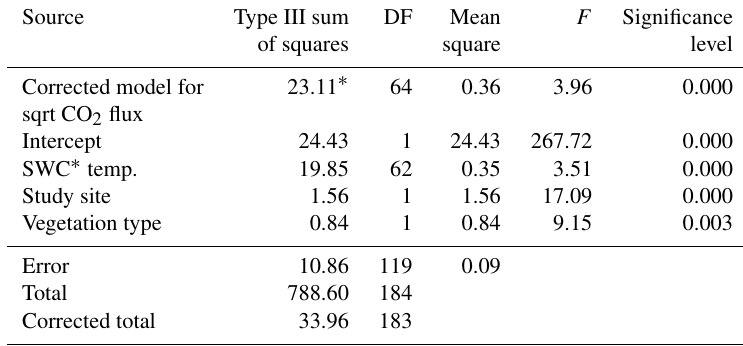
Table 3. Factors affecting soil CO 2 effluxes including the statistical significance level. Source Type III sum DF Mean F Significance of squares square level Corrected model